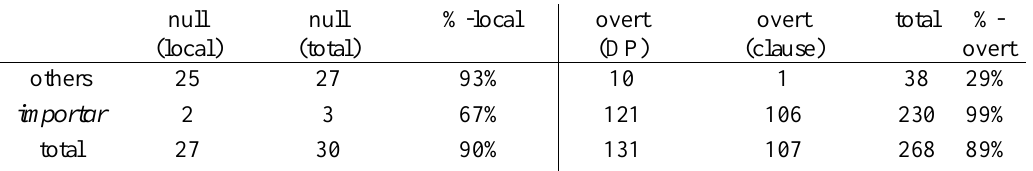
Table 4: (Non-)local identification of null subjects with psych verbs in adjunct infinitives null null %-local overt overt total %- (local) (total) (DP) (clause) overt others 25 27 93% 10